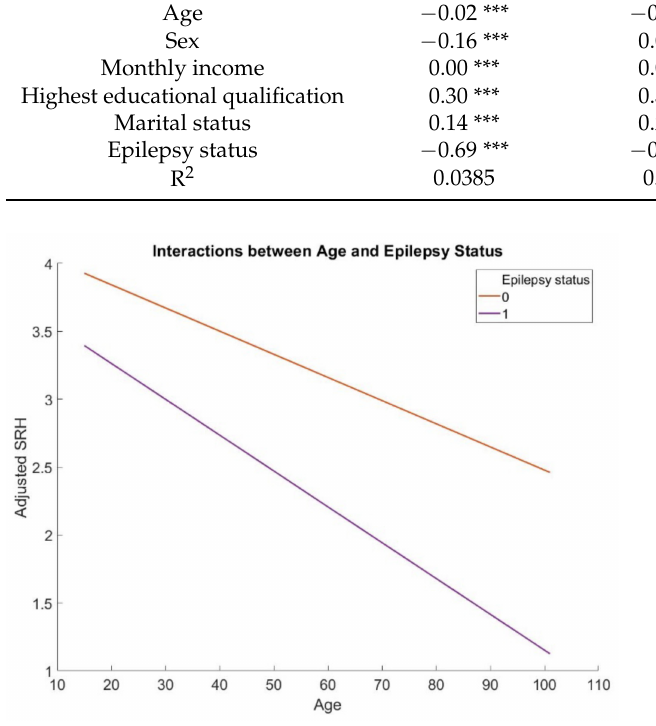
Figure 1. The interactions between age and epilepsy status in predicting